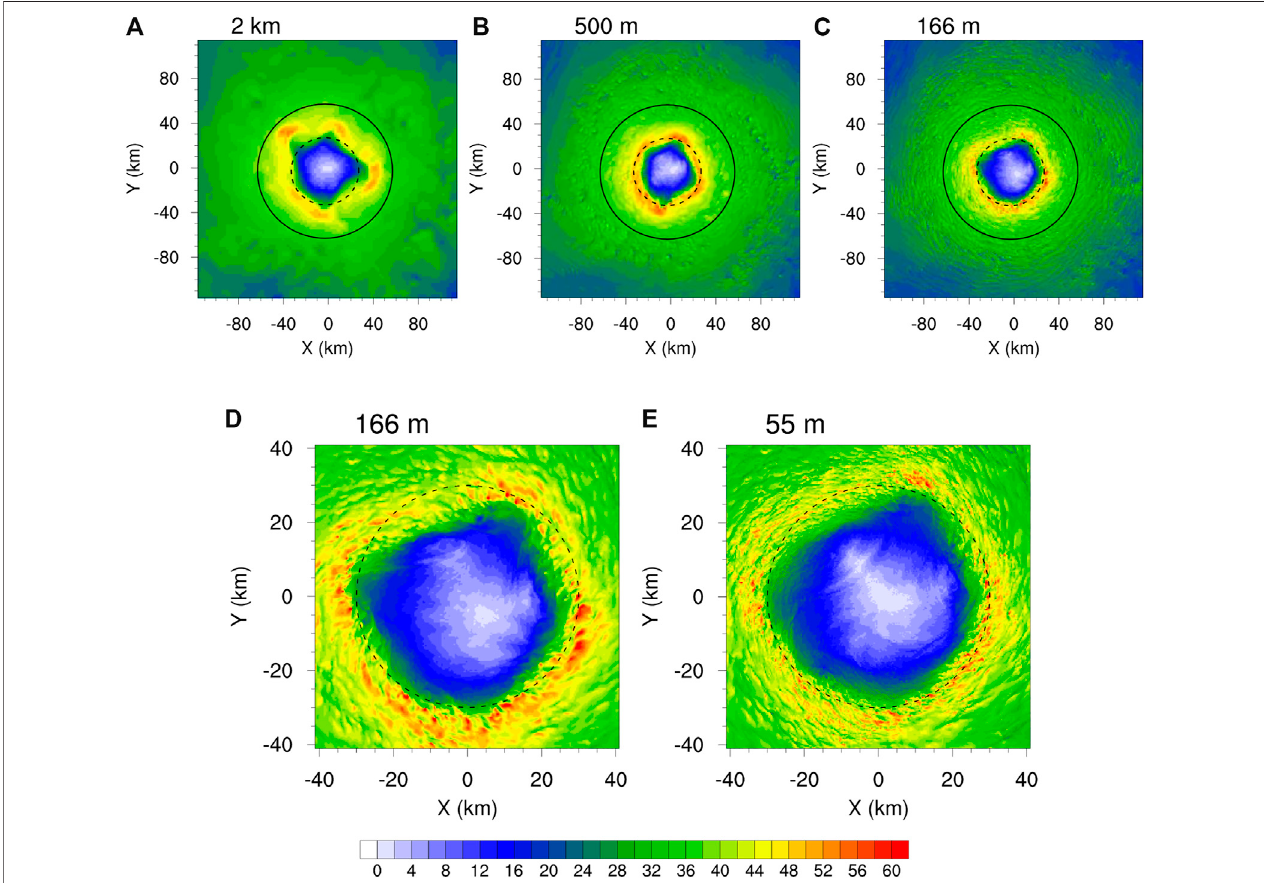
FIGURE 2 | Horizonal cross-section of instantaneous 10-m wind speed (m s − 1 ) at t (cid:2) 9 h of the simulation from the grid spacings of (A) 2 km, (B) 500 m, and (C) 166 mwiththedomainsizethesameasd05; (D) and (E) areasin (C) butwiththedomainsizethesameasd06.Dashandsolidcirclesindicatetheradiiof30and60 km from the TC center,